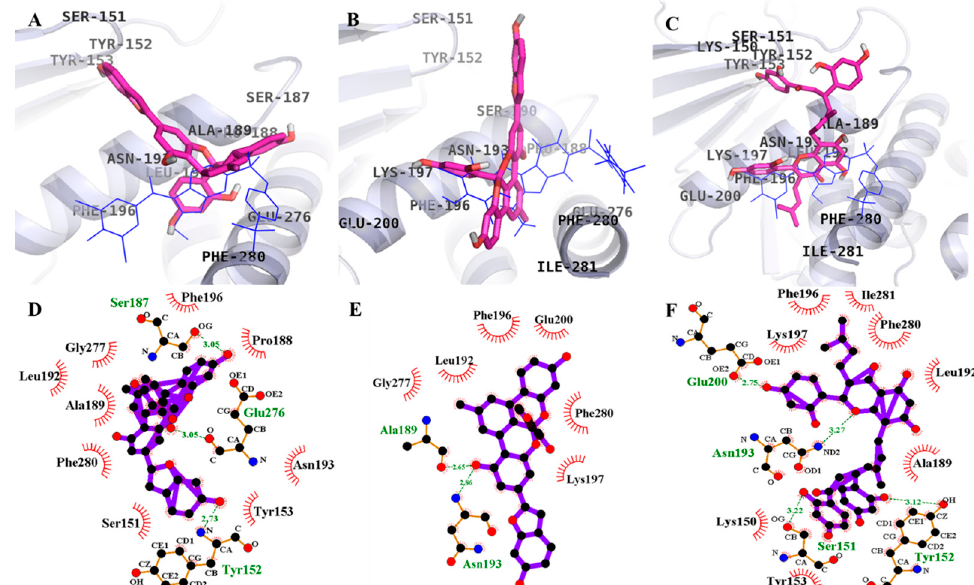
Figure 2. Molecular docking models for PTP1B inhibition at allosteric site by 1 – 3 along with reported inhibitor compound 2 (blue line). 1 ( A ); 2 ( B ); and 3 ( C ). 2D ligand interaction diagram of PTP1B inhibition by 1 ( D ); 2 ( E ); and 3 ( F ). Schematic representation of interaction between ligands 1 – 3 and the PTP1B, thick purple stick models present the compounds 1 – 3 , green dotted lines are hydrogen bonds, and dashed half-moons present hydrophobic interactions with the corresponding amino acid residues of the enzyme.